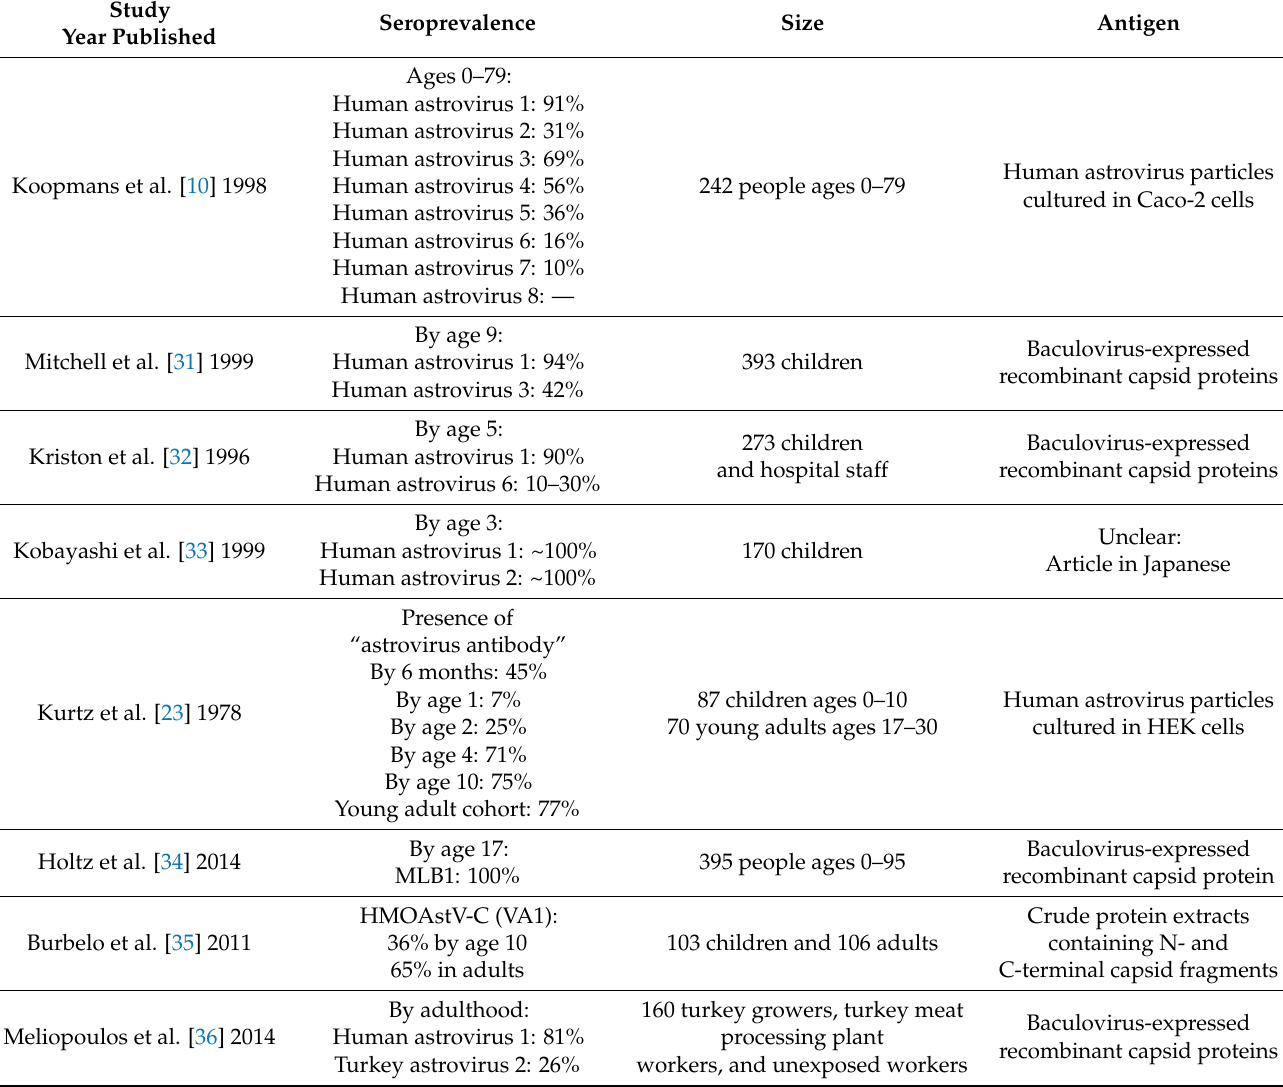
Table 3. Summary of previous human astrovirus serological